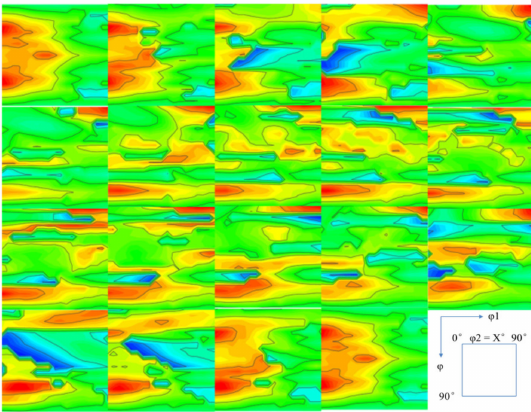
Figure 4. The ODF of cold rolled Ag sheets.